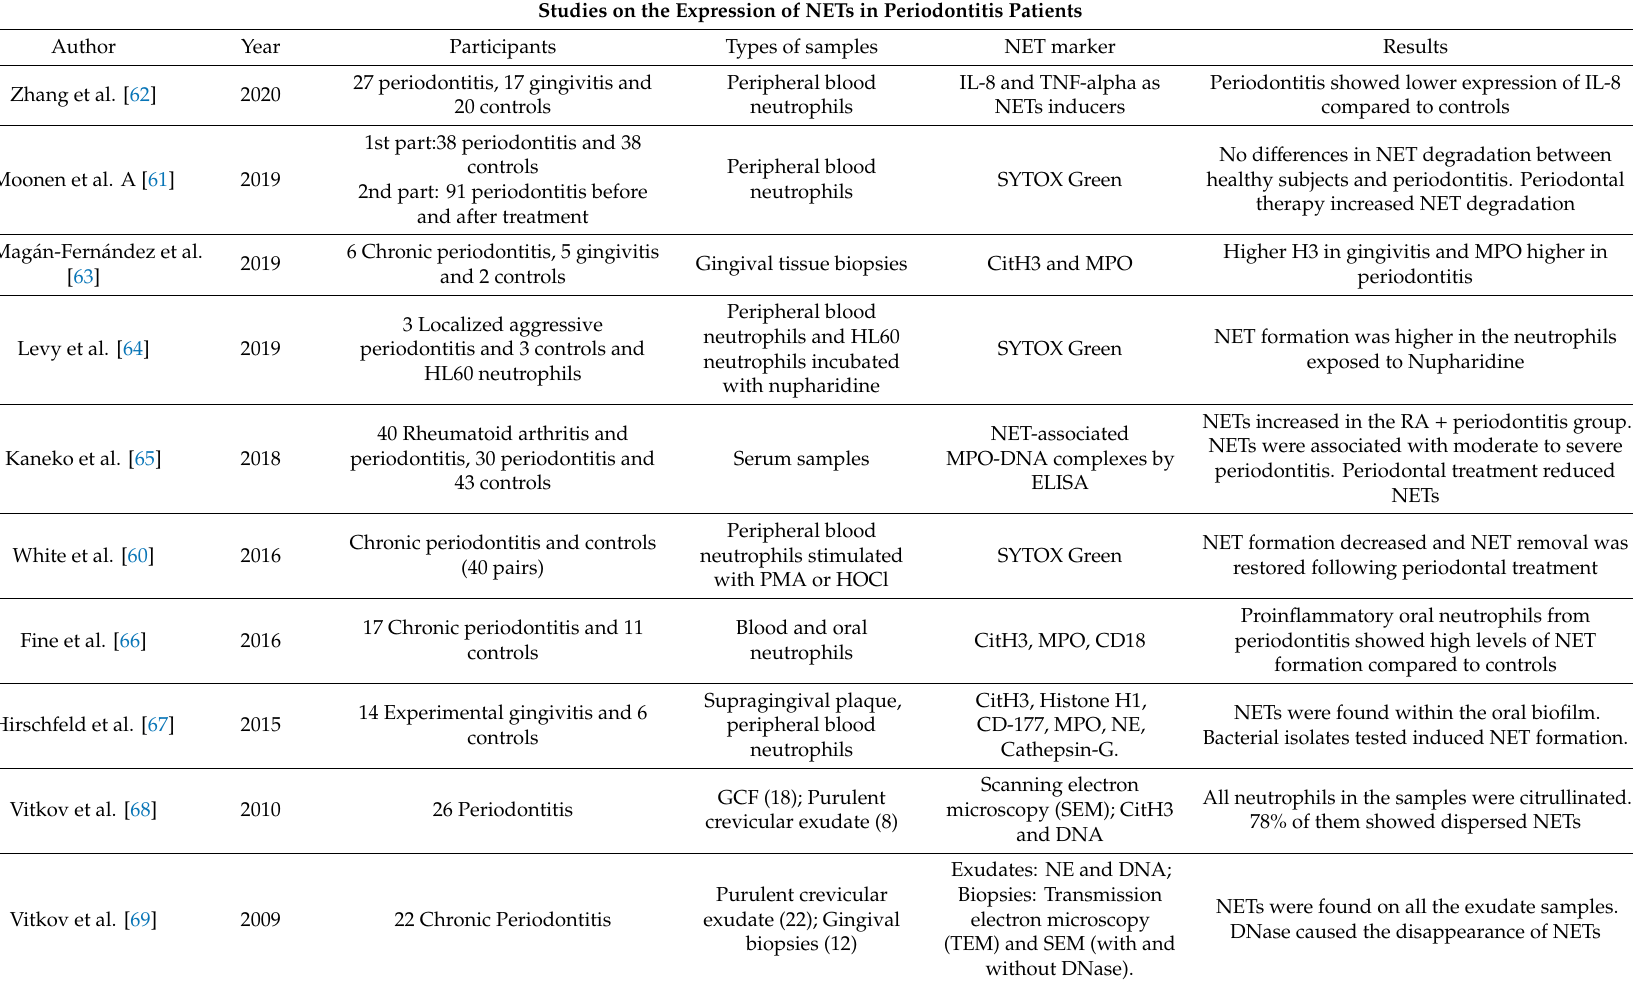
Table 1. Summary table of the studies assessing the role of neutrophil extracellular traps (NETs) in periodontitis and the induction of NET formation by periodontal